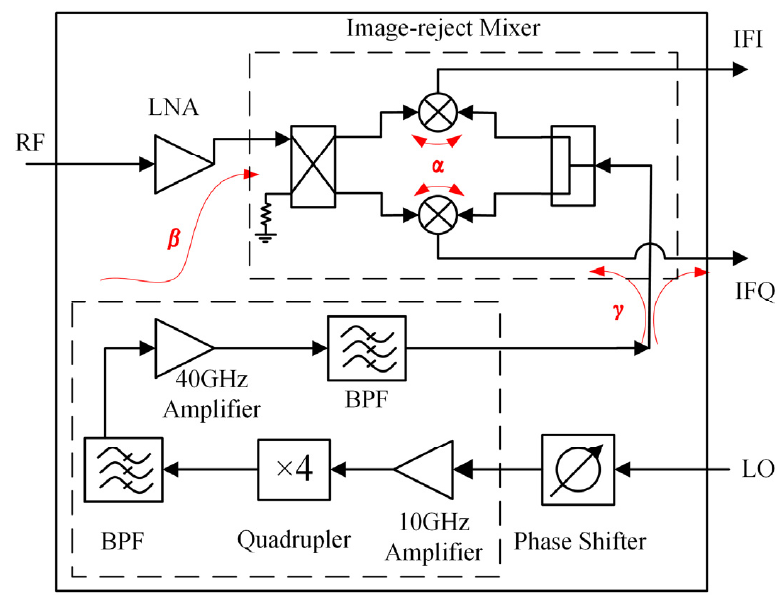
Figure 1. Block diagram of receiver MMIC and coupling paths.